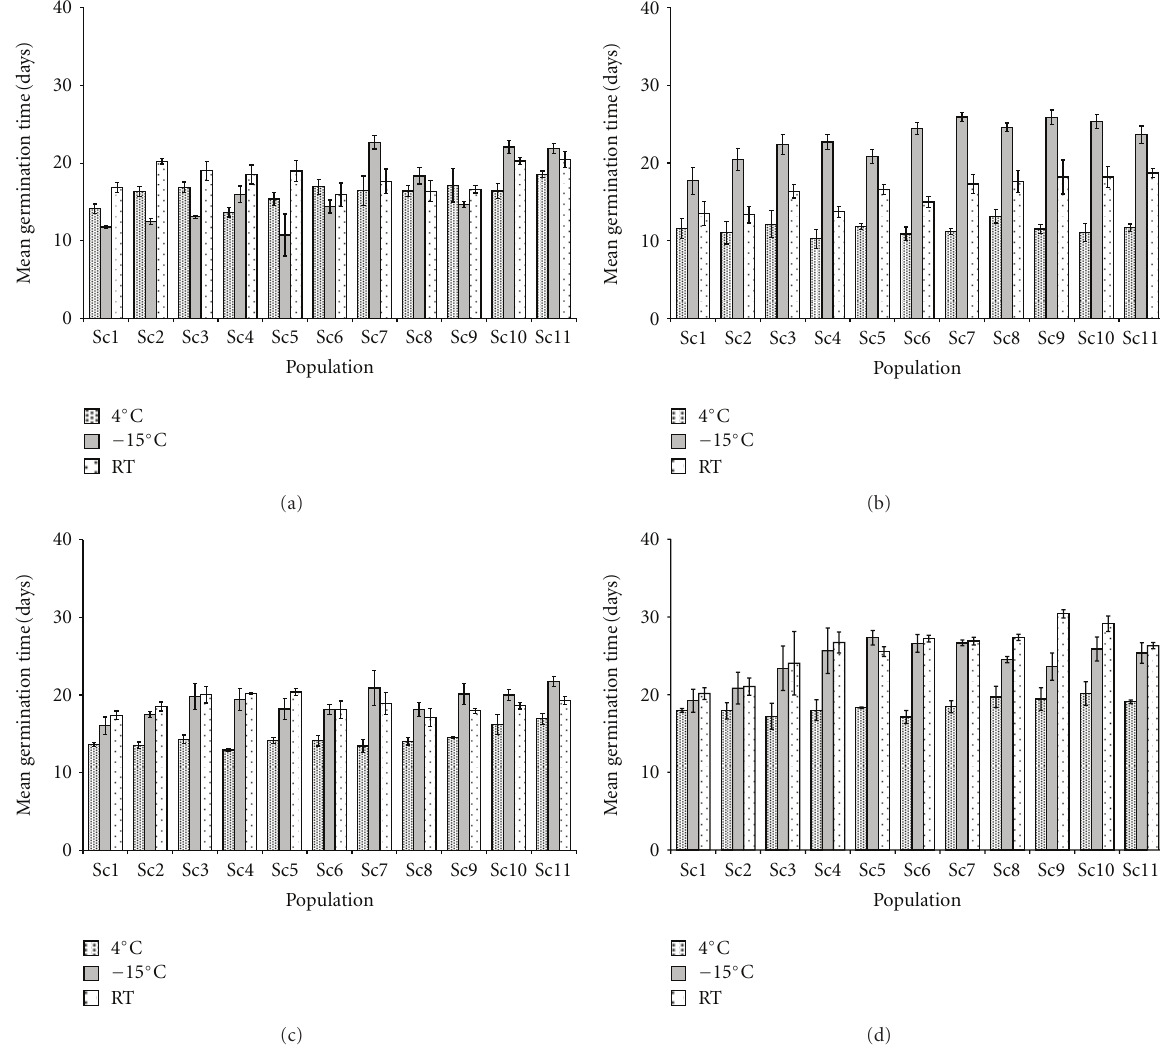
Figure 4: E ff ect of storage conditions and storage period on mean germination time in populations of Swertia chirayita (a) 6 month; (b) 12 month; (c) 18 month; (d) 24 month ( vertical bars indicate the standard deviation; 30 seeds × 3 replicates per population used; RT: room temperature